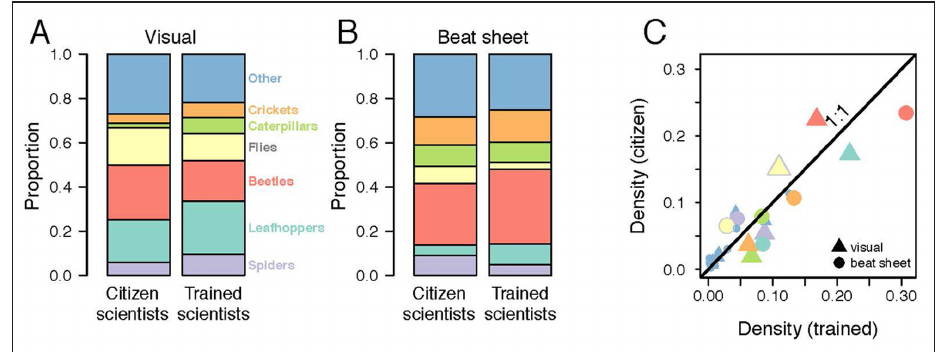
Figure 4: Comparison of the proportion of arthropods observed by citizen scientists versus trained scientists using (a) visual surveys in 2015 and (b) beat sheet surveys in 2016. (c) Comparison of absolute density estimates of different arthropod groups based on whether the data were collected by citizen or trained